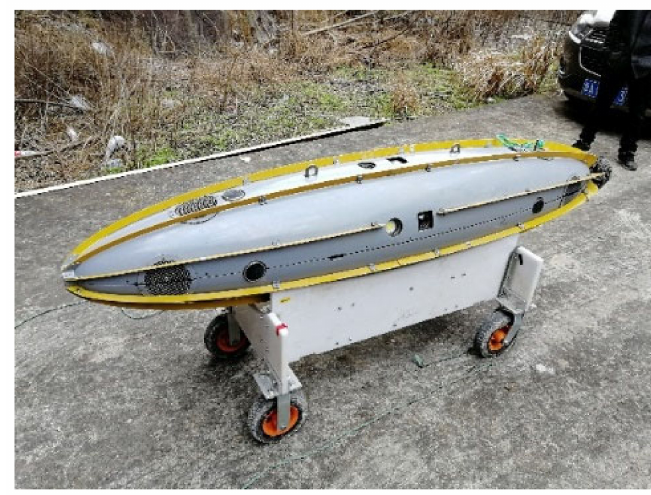
Figure 1. Tunnel-detection AUV (AUV-T).